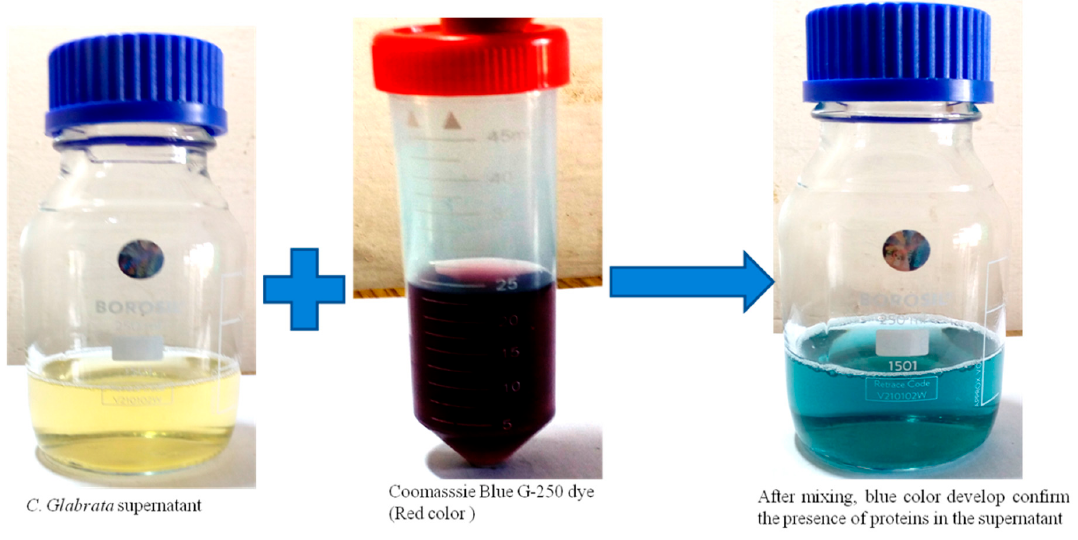
Figure A1 . A simple protein-dye binding assay to assess the presence of protein in the supernatant. Figure A1. A simple protein-dye binding assay to assess the presence of protein in the